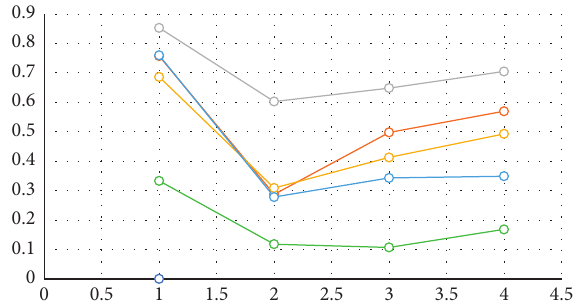
Figure 4: The graphical portrayal of the interpreted WSMs be- tween P and D J ( J � 1 , 2 , 3 , 4 )